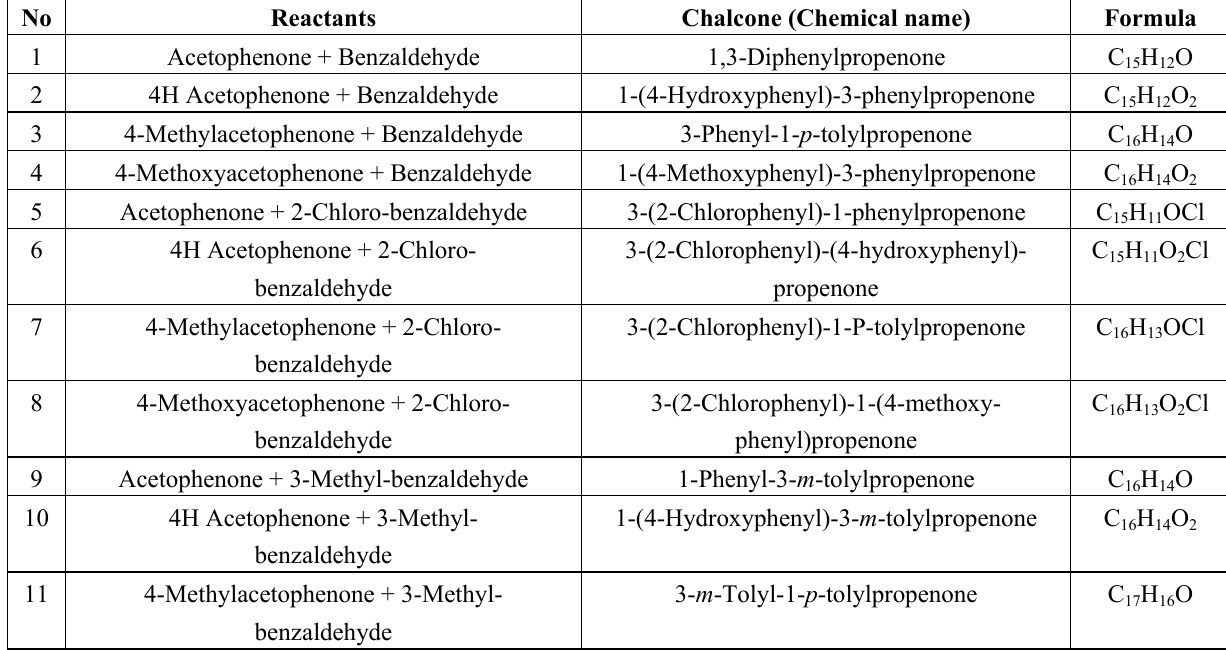
Table 1. Chemical data for compounds 1–25